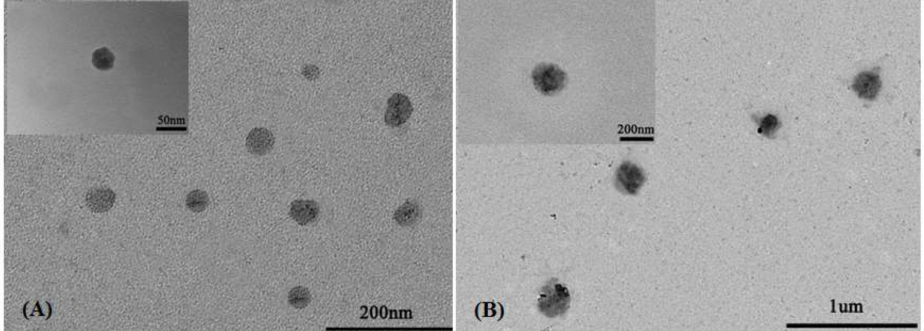
Figure 6. TEM images of blank MIX1 micelles ( A ) and DOX-loaded MIX1 micelles ( B